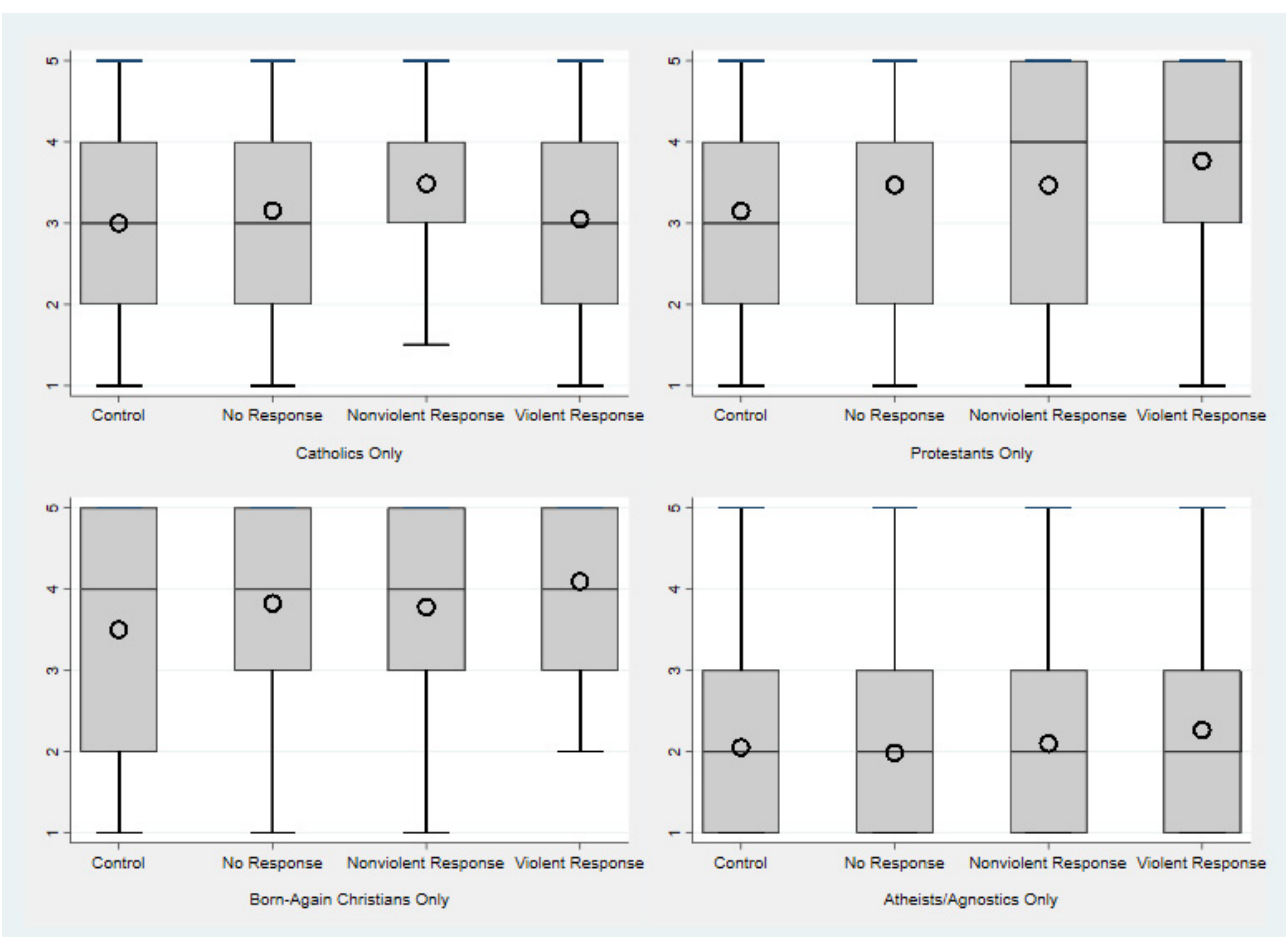
Figure 3. The causal effects of persecution discourse on perceptions of threat to religious liberty across conditions and by religious subsample. The top left panel illustrates the effects of persecution discourse on the Catholic subsample’s perceptions of threat to religious liberty. The top right panel illustrates the effects of persecution discourse on the Protestant subsample’s perceptions of threat to religious liberty. The bottom left panel illustrates the effects of persecution discourse on the born-again Christian subsample’s perceptions of threat to religious liberty. For comparison, the bottom right panel illustrates the effects of persecution discourse on the atheist and agnostic subsample’s perceptions of threat to religious liberty (also see Appendix C). Key : boxes represent the interquartile range; circles represent the mean; thick lines represent the median; whiskers represent minimum and maximum values.